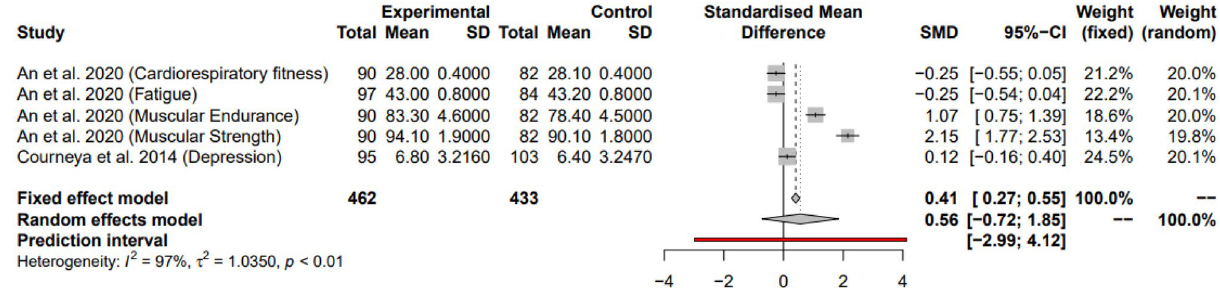
Figure 8. Random effects model showing the effects of adding resistance interventions to endurance interventions on adjuvant therapy related side effects compared to using endurance interventions alone. Positive effect sizes favour the exercise